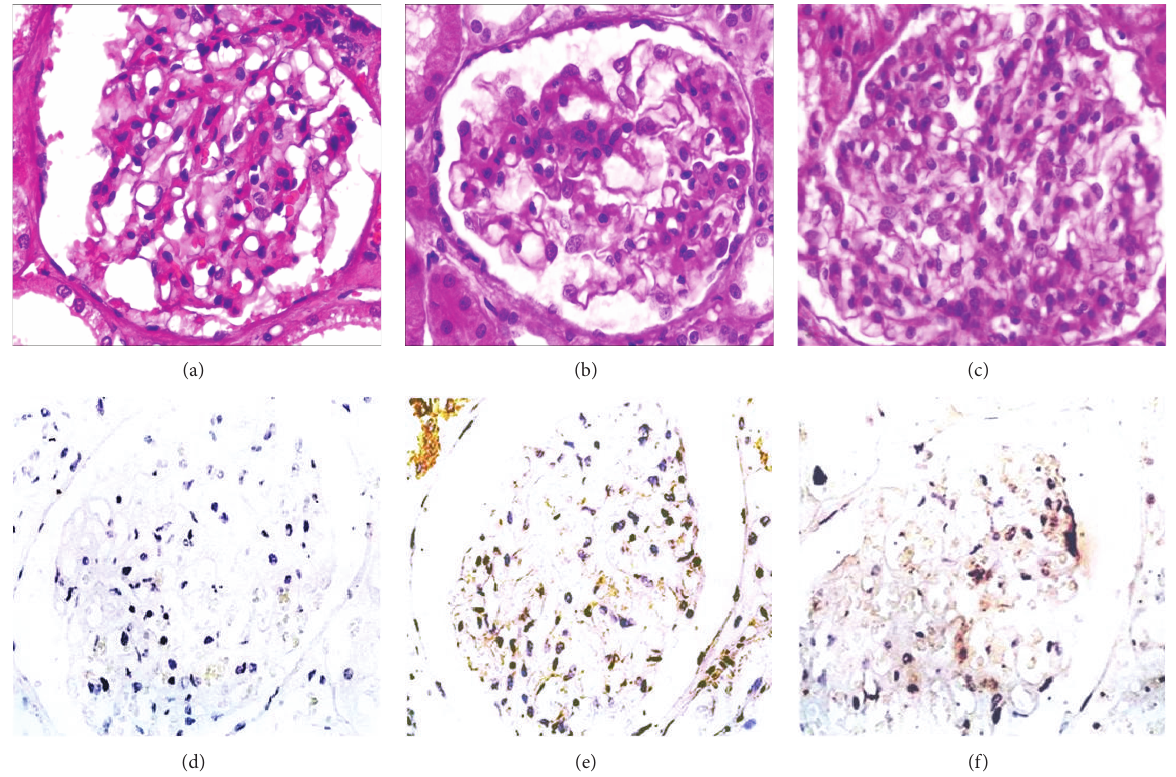
Figure 7: The expression of Fas receptor in renal tissue of LN patients and HS by IHC. Superior panel stained by H and E. Inferior panel, IHC for Fas. (a) and (d) HS biopsies; (b), (c), (e), and (f) show a representative of LN. (b) and (e) LN Class-IV. (c) and (f) LN Class-III.